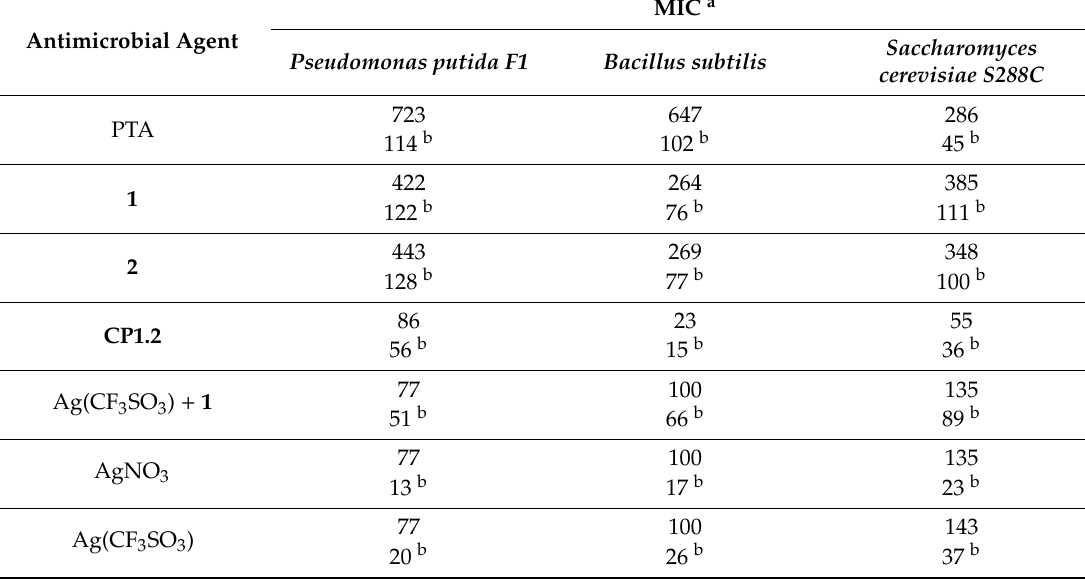
Table 2. Antimicrobial activity of PTA, phosphabetaines 1 and 2 , and the coordination polymer CP1.2 expressed in minimum inhibition concentrations (MIC) MIC a Antimicrobial Agent Saccharomyces Pseudomonas putida F1 Bacillus subtilis cerevisiae